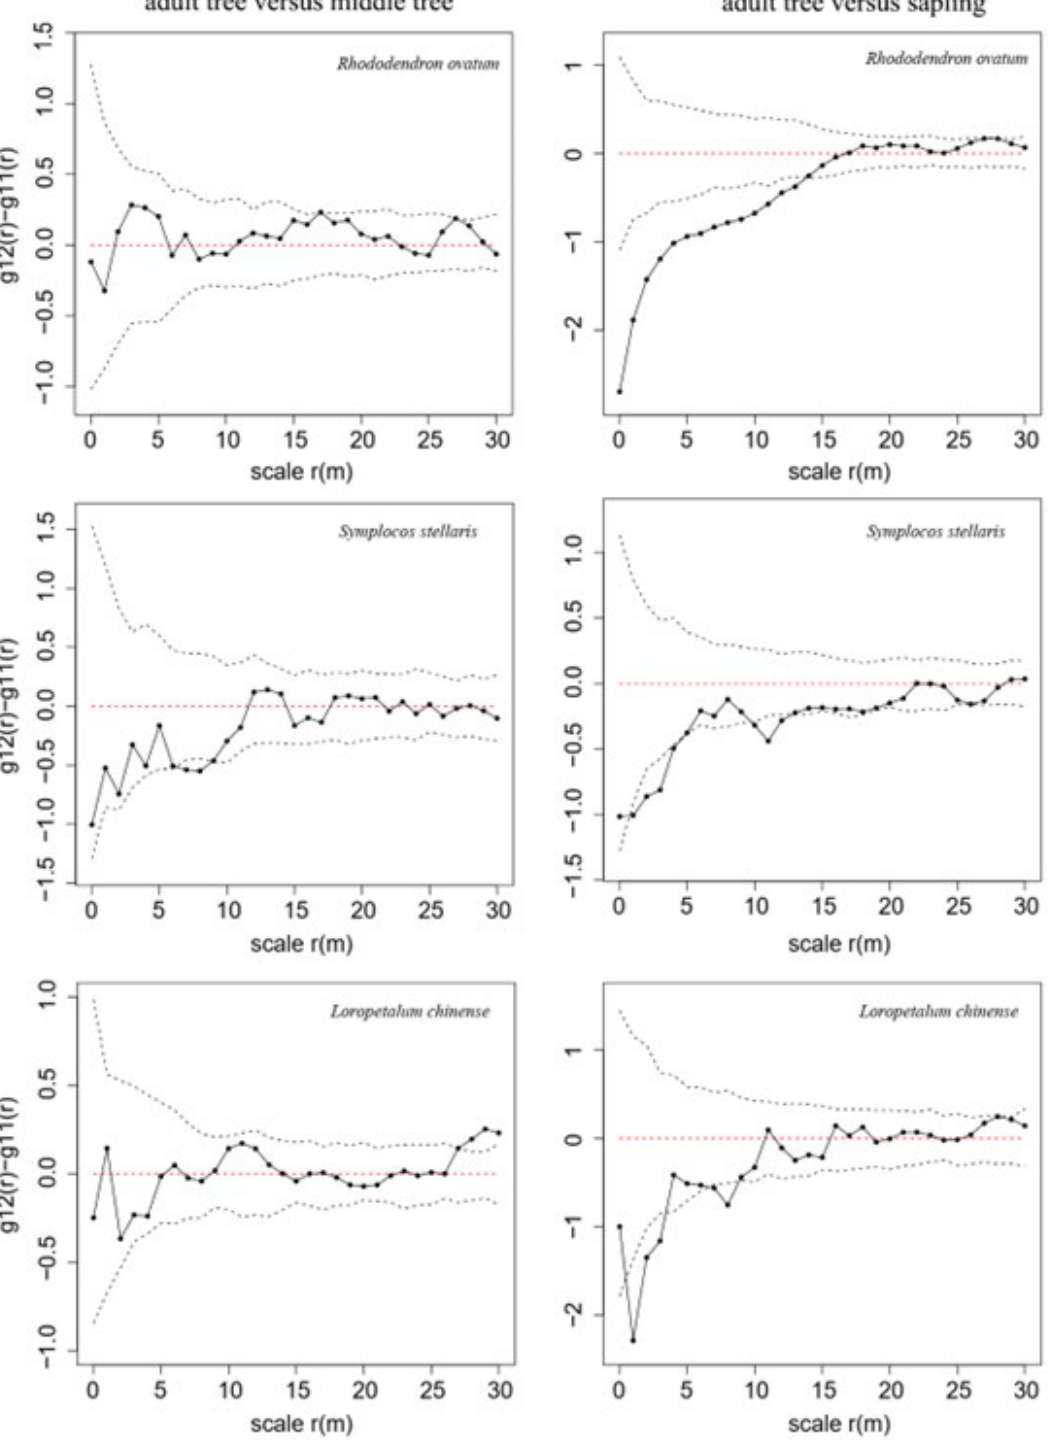
Figure 7. Juvenile–adult ( left ) and sapling–adult ( right ) comparative analyses of Rhododendron ovatum , Symplocos stellaris , and Loropetalum chinense with a random labelling case–control design.